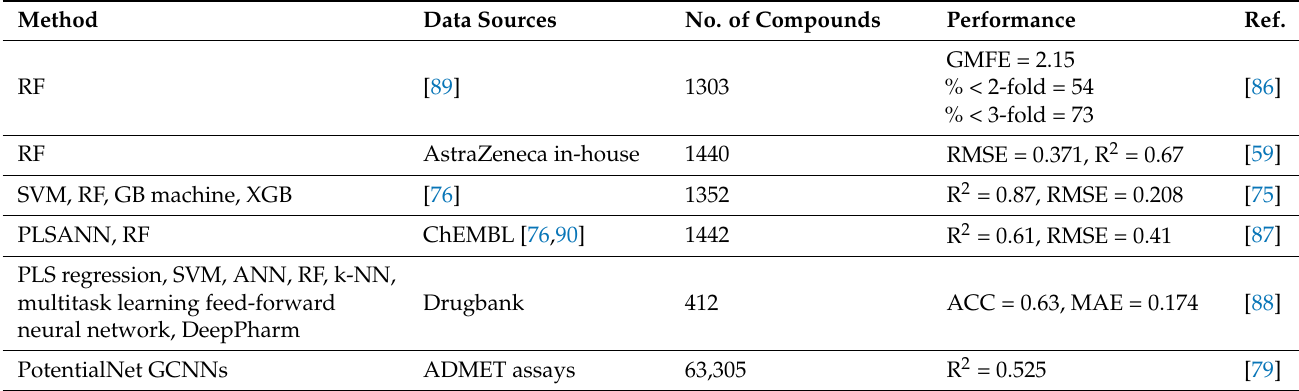
Table 4. Summary of recent AI-based studies predicting V d